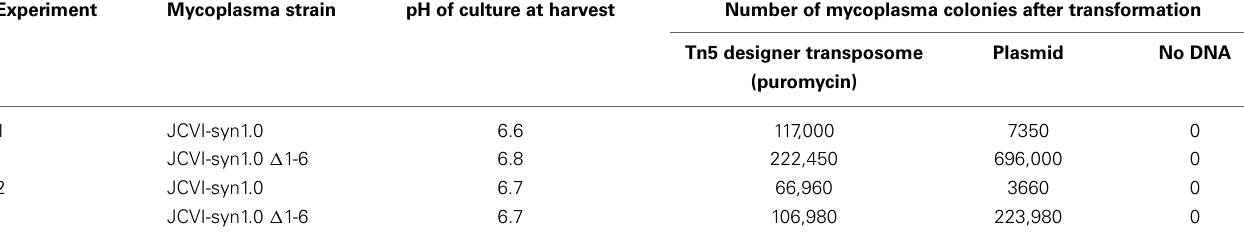
Table 2 | Protection of transposase-loaded DNA from restriction.